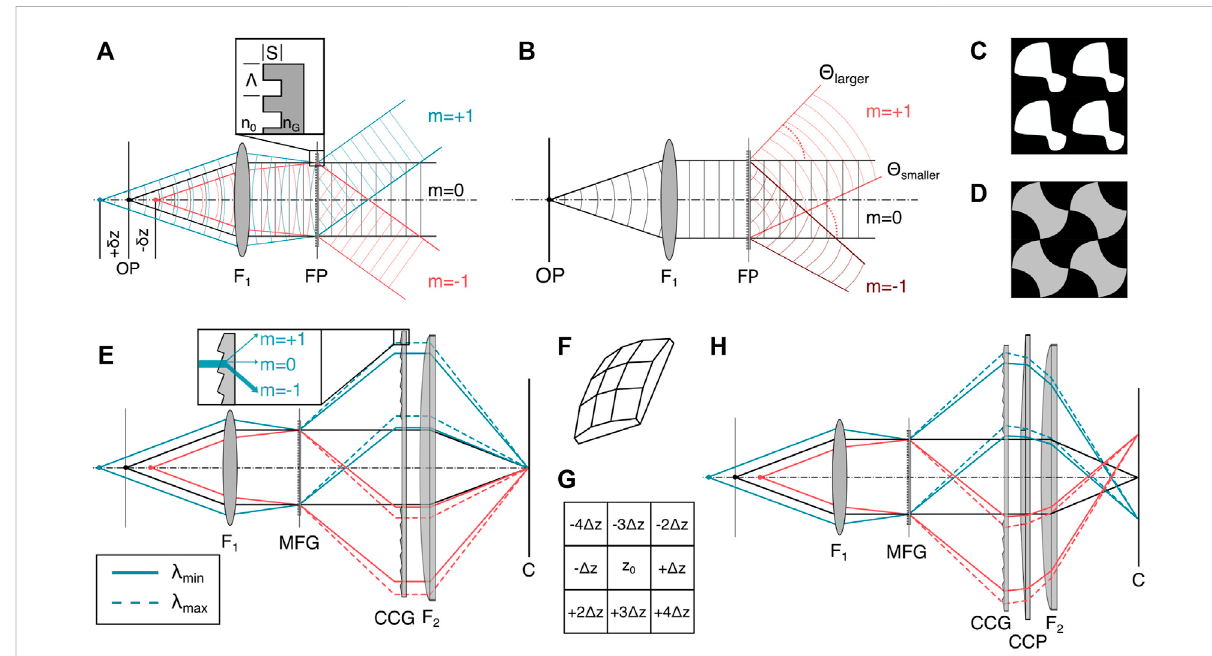
FIGURE 4 Diffractive image splitting. (A) The binary MFG with etch depth S , motif period Λ and refractive index n G splits the incident light from the sample intoasetofdiffractionorders. (B) Eachsub-imageproducedbytheMFGisatraditionalwide- fi eldimagecontainingbothin-focusinformationandas an out-of-focus-blur. The diffraction angle θ depends on diffractive order m, wavelength λ and motif spacing Λ according to Eq. 6. (C) Binary 2D motif for a 3 × 3 order grating with phase step ∈ [0, π ] [21]. (D) Binary 2D motif for a 3 × 3 order grating with phase step ∈ [0, 0.84 π ] [49]. (E) The MFG diffracts light with an outward smear that depends on the incident wavelength. A blazed chromatic correction diffractive grating (CCG) directs most of the light into the m = − 1 diffractive order, with dispersion opposite that of the MFG. (F) 3D schematic of the correction prism (CCP). (G) Distribution of axially displaced image planes of thesame lateralFOV on an image sensor for a9-plane prism. (H) The CCP isplaced behind the CCG to laterally separate the images on the sensor. Figures inspired by [21]. F 1 : objective lens, FP: Fourier plane, MFG: multi-focus grating, C: